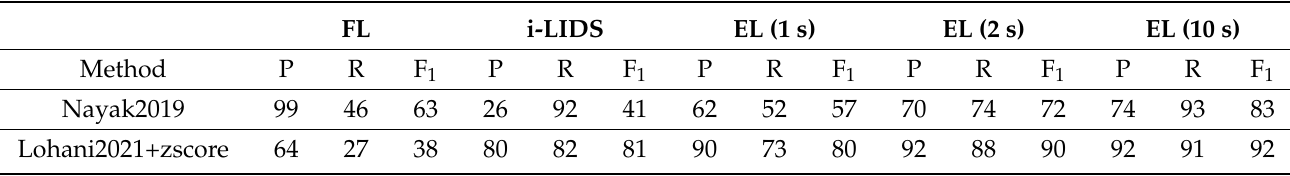
Table A1. Results as percentage on view 1 of i-LIDS test